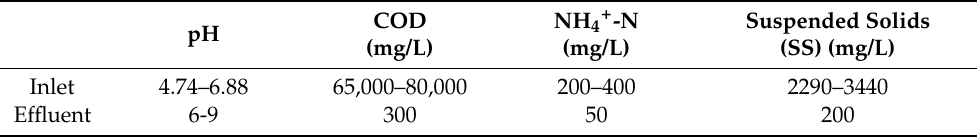
Table 1. Quality of raw wastewater and treated water.